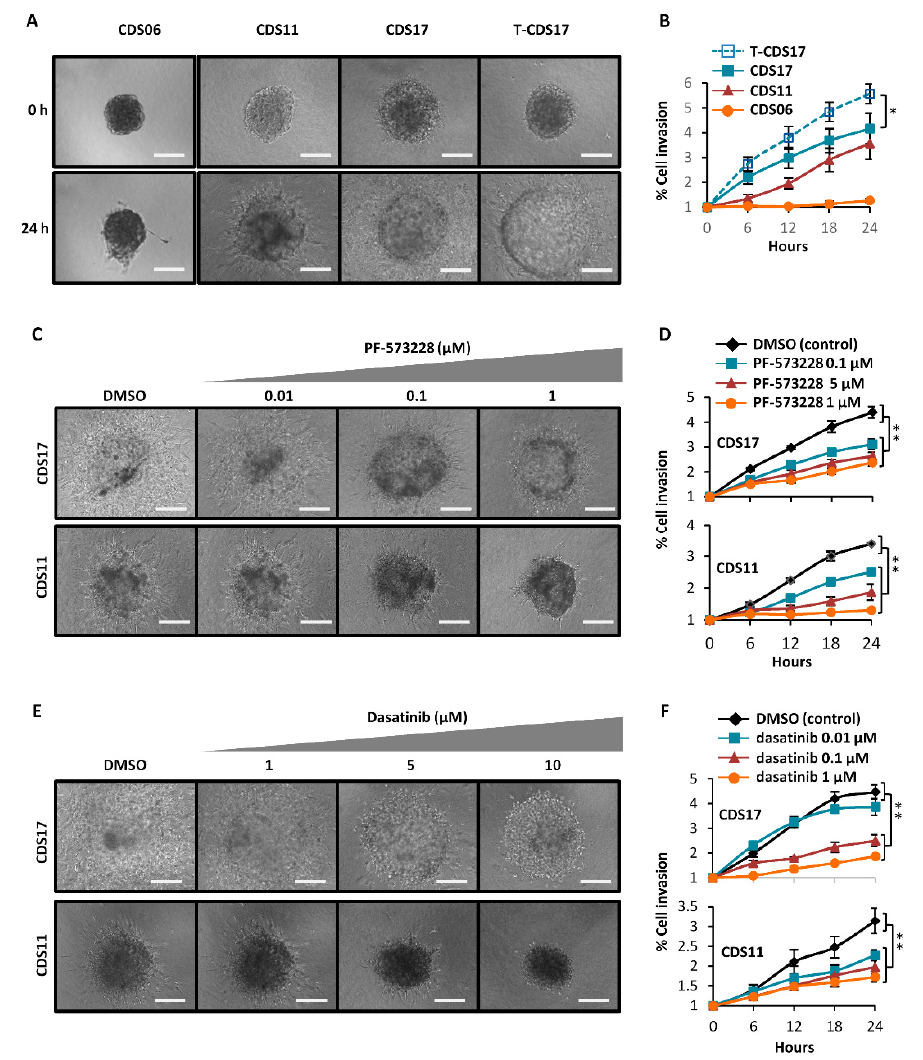
Figure 6. Invasive ability of chondrosarcoma cell lines. ( A , B ) Analysis of the invasive properties of the indicated cell lines using 3D spheroid invasion assays. Representative images of the 3D invading spheroids at the initial and final time points ( A ) and quantification of the invasive area ( B ) are presented. ( C , F ) E ff ect of increasing concentrations of PF-573228 ( C , D ) or dasatinib ( E , F ) on the invasive ability of CDS11 and CDS17 cells. Representative images of the 3D spheroids treated with the indicated concentrations of PF-573228 ( C ) or dasatinib ( E ) for 24 h and quantification of the invasive area after each treatment ( D , F ) are presented. Scale bars = 200 µ m. Error bars represent the SD, and asterisks indicate statistically significant di ff erences between the indicated series (* p < 0.05; ** p < 0.01; two-sided Student’s t-test). (DMSO: Dimethyl